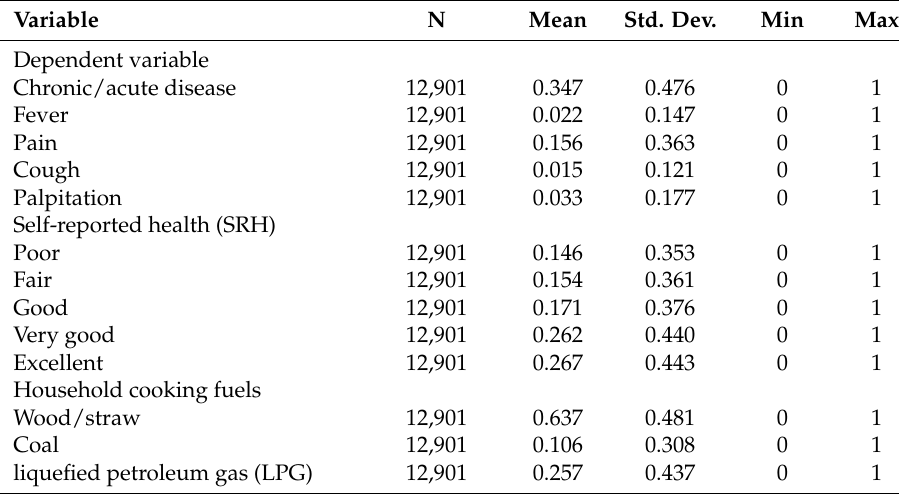
Table 1. Descriptive statistics: CFPS